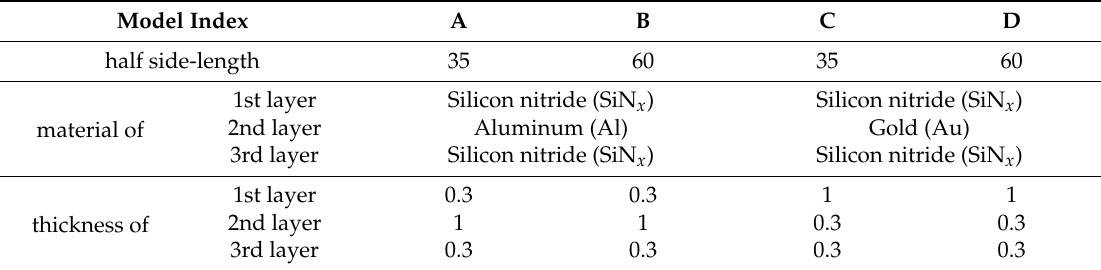
Table 1. Geometries and dimensions of three-layer CMUT membranes ( µ m).